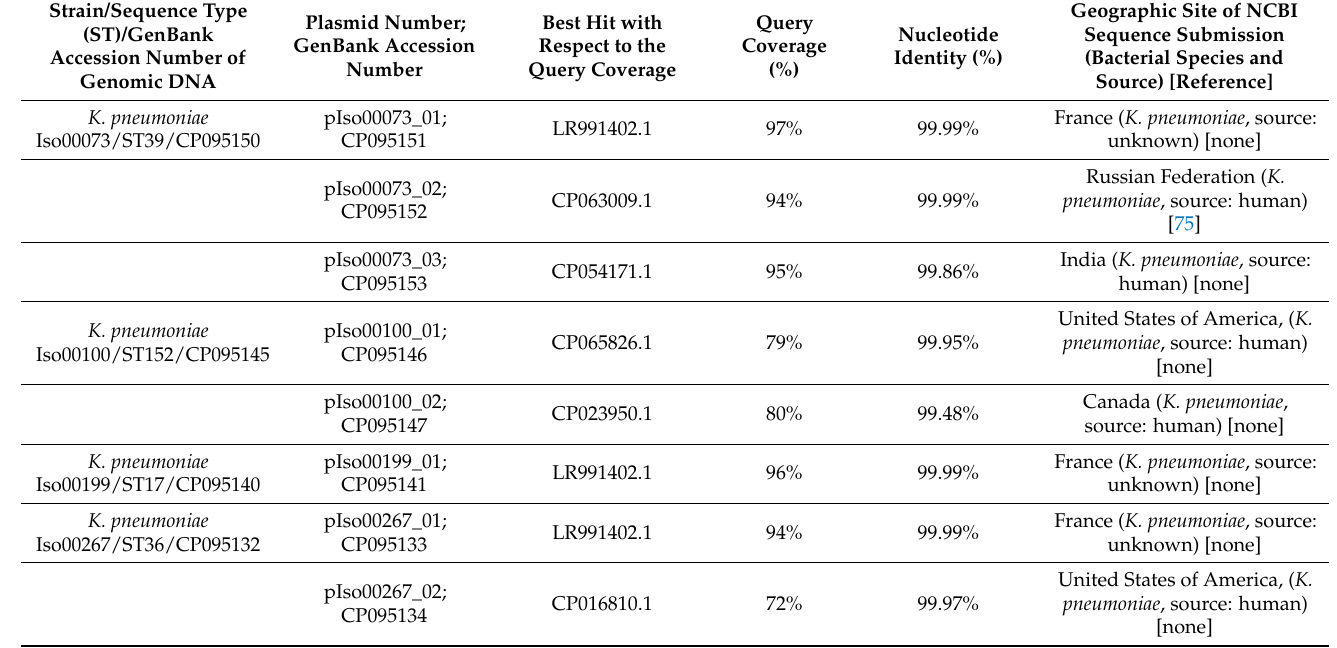
Table A1. Plasmids carrying antimicrobial resistance genes and disinfectant resistance genes and genetic similarity according to BlastN matching with previously published plasmids in the NCBI database, as well as the previous sites of